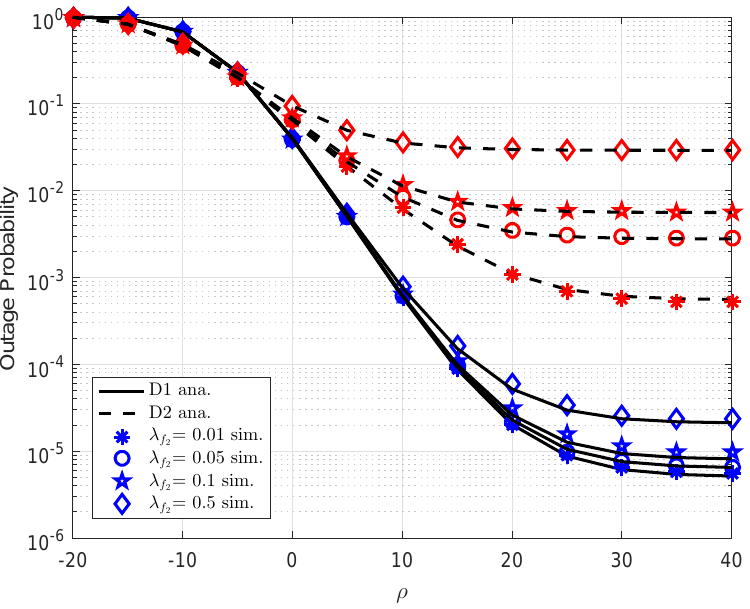
Figure 7. Consideration on outage of D 1 and D 2 versus ρ as varying λ f